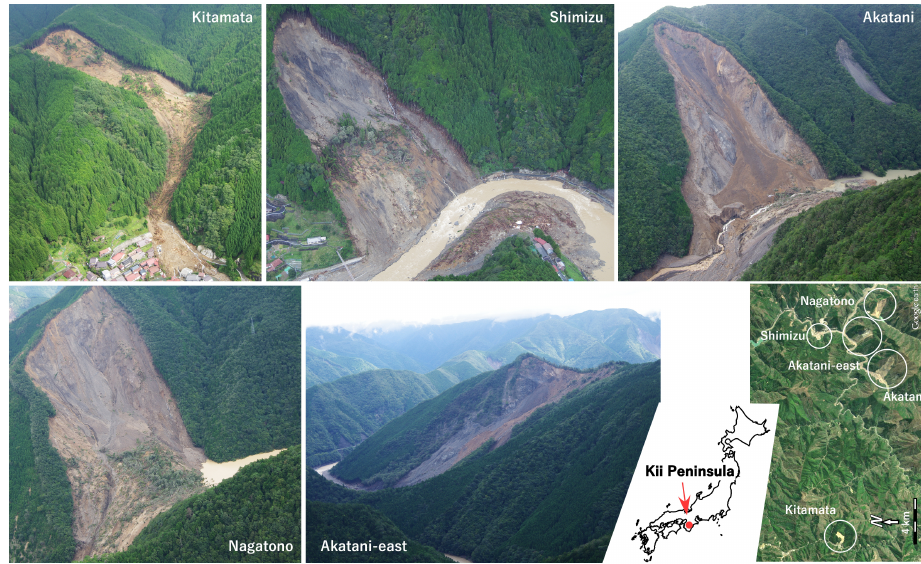
Figure 1. Photographs of the five landslides studied, taken by M. Chigira just after Typhoon Talas. The locations of the photographs are also indicated (images taken by Chigira and partly extracted from Chigira et al.,